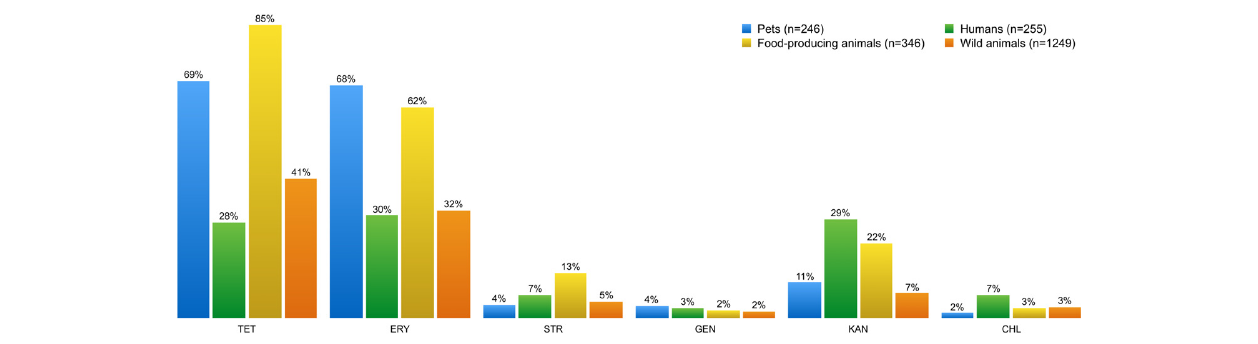
FIGURE 6 | Percentage of phenotypic antibiotic resistance detected in Enterococcus spp. isolates from each of the four sampling groups. Enterococci isolates showed high resistance levels to tetracycline and erythromycin, regardless of the source. However, food-producing animals and pets stand out from the other sampling groups. Streptomycin, kanamycin, and chloramphenicol-resistant enterococci are more frequent in samples from humans than from other sources. TET, tetracycline; ERY, erythromycin; STR, streptomycin; GEN, gentamicin, KAN, kanamycin; CHL, chloramphenicol.